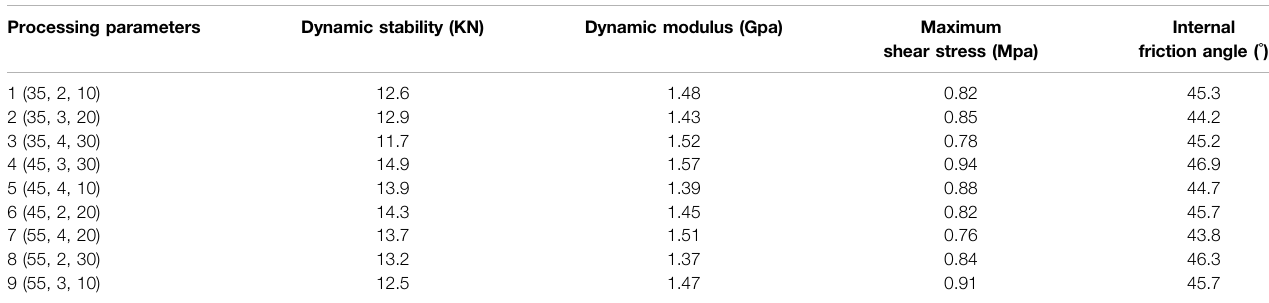
TABLE 9 | Veri fi cation of the test results. Processing